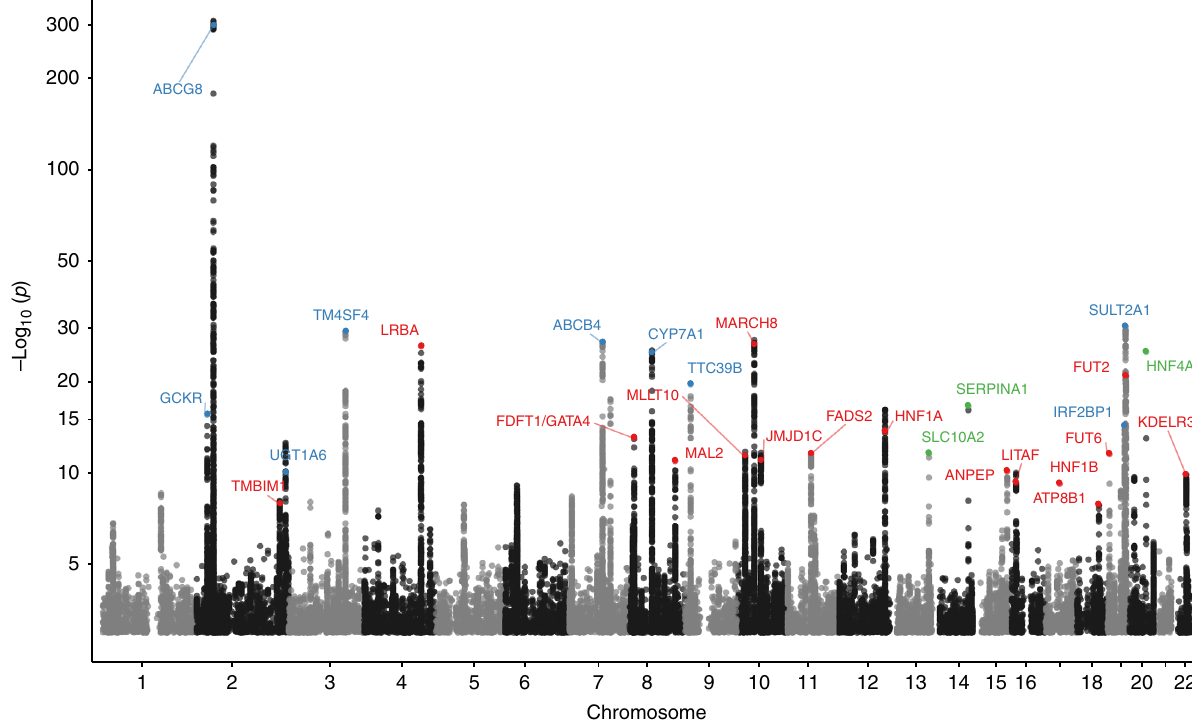
Fig. 2 Manhattan plot for gallstone disease meta-analysis association results ( N cases = 27,174 and N controls = 736,838). Variants are plotted by chromosomal position ( x -axis) and − log 10 P -values ( y -axis). A chi-square test was used when testing for association. Green = Novel loci represented by low-frequency variants, red = novel loci represented by common variants, blue = reported gallstone disease